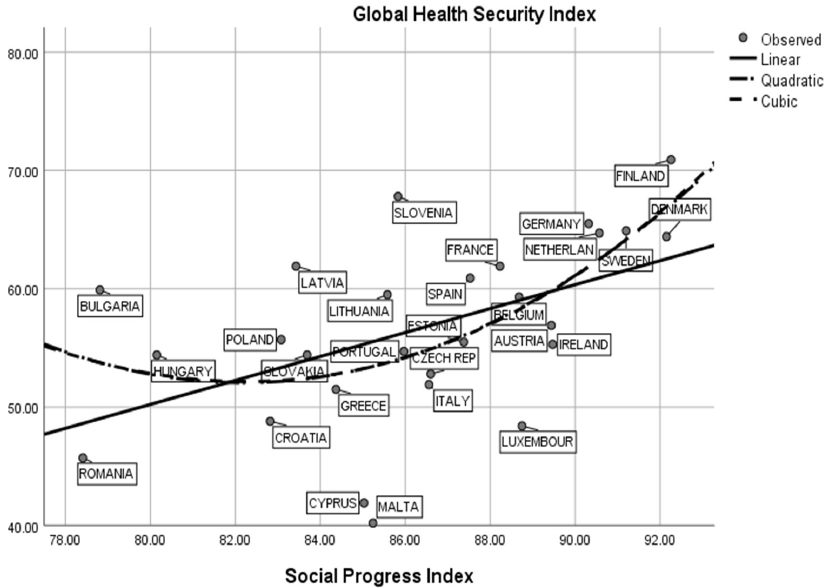
Figure 3. Correlation between the Social Progress Index and the Global Health Security Index. Au- thor’s quantitative determination based on statistical data presented in Section 2 (Research Meth- ods).